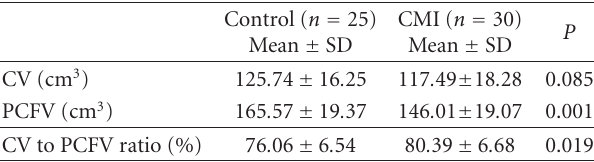
Table 4: Comparison of CV, PCFV, and CV to PCFV ratio between the two groups.